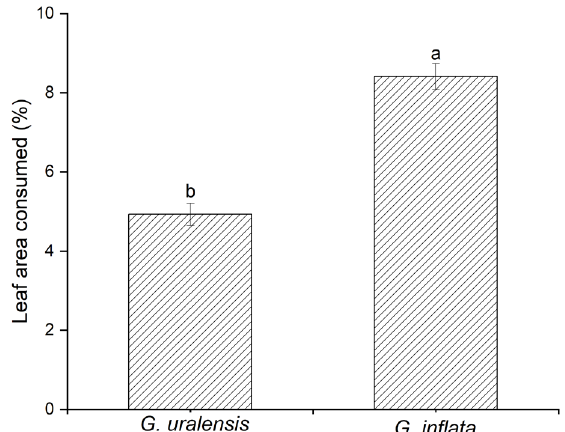
Figure 1. The percentage (%) of the leaf area consumed by adults of Altica deserticola in two licorice ( Glycyrrhiza ) species. Different letters denote significant differences between the means of the same color columns (P < 0.01).